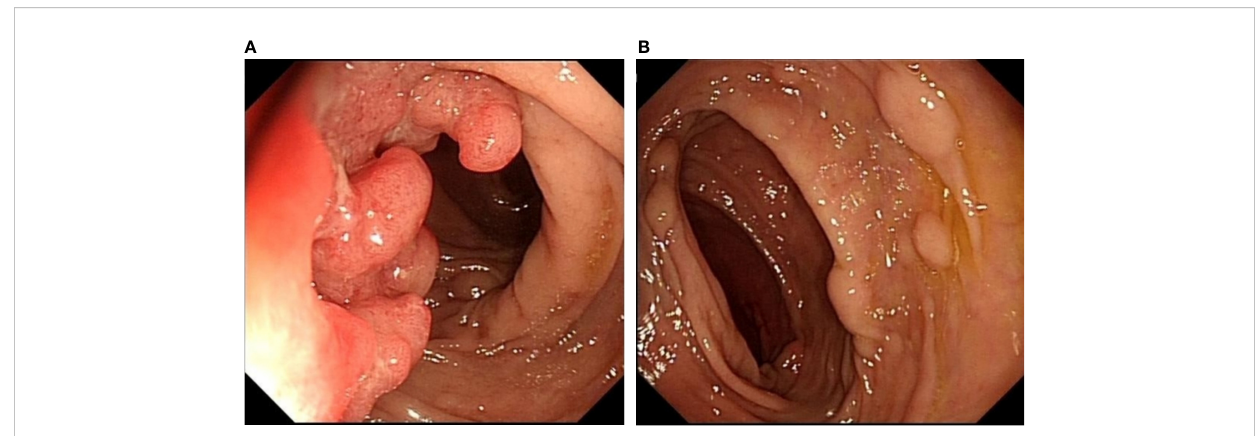
FIGURE 1 Colonoscopy showing an ulcerative mass, approximately 3 * 3 cm in size, located in the sigmoid colon 15 cm proximal to the anal verge (A) . Scattered raised lesions with a size of 0.4 – 1.0 cm located in the colon and rectum (B)